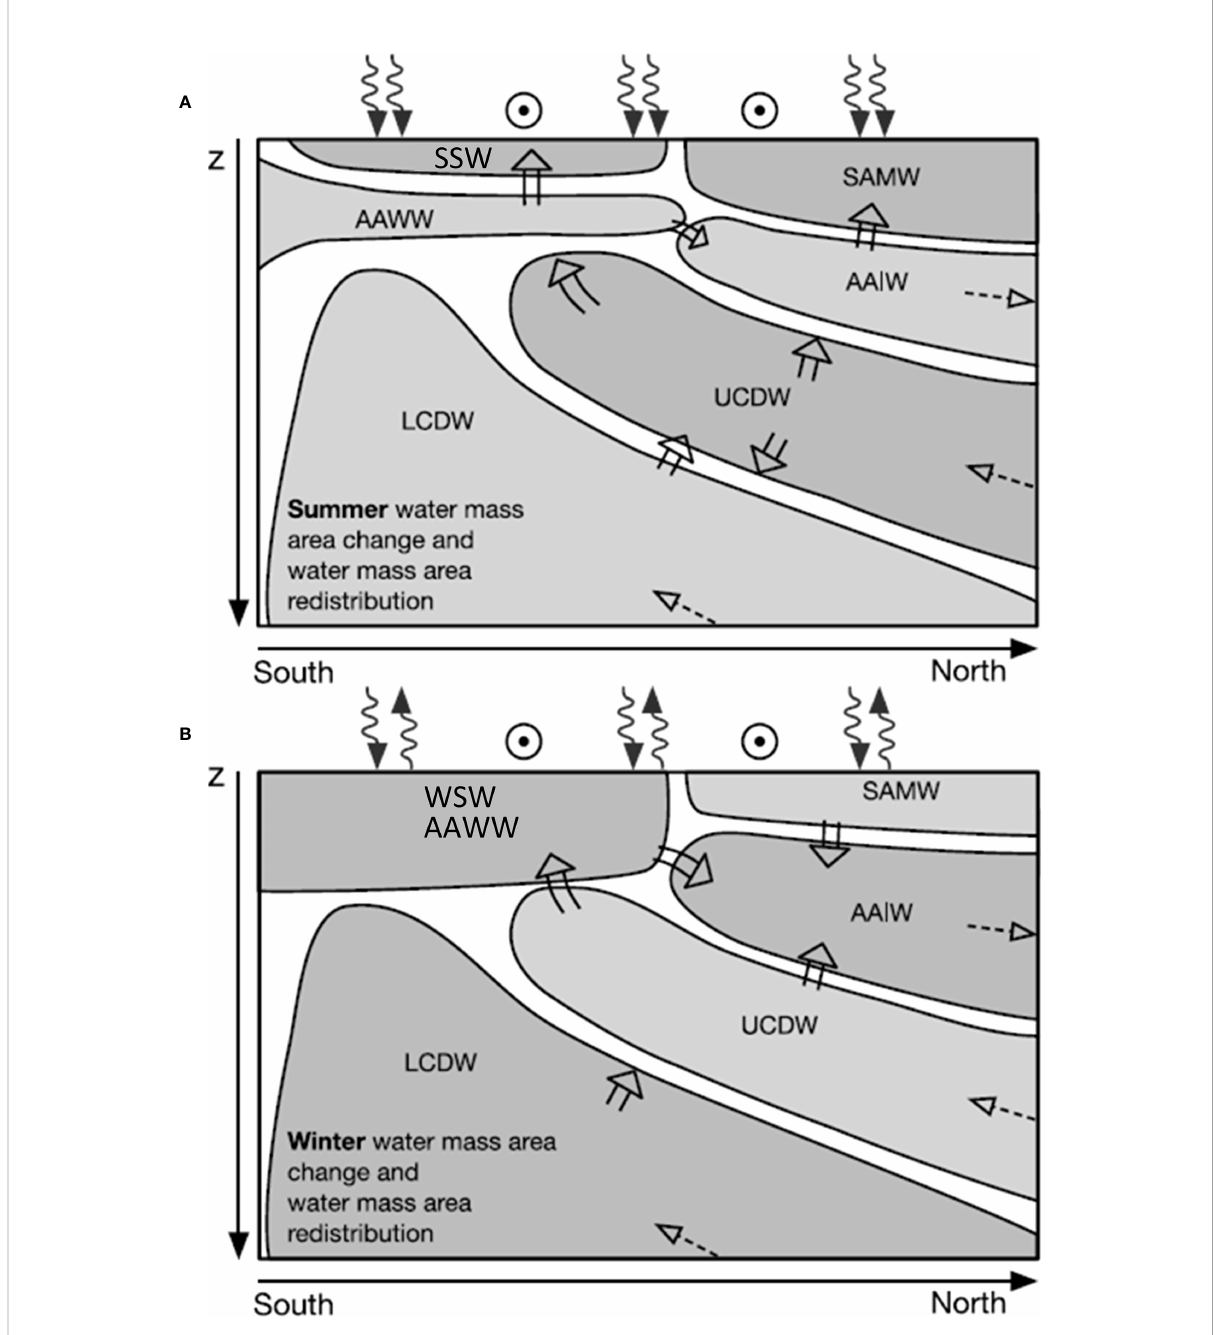
FIGURE 3 Schematic showing the changes in the distributions of water masses during (A) summer and (B) winter in depth vs. latitude coordinates. The black circles with dots represent the direction of the zonal winds out of the page. SSW, Summer Surface Water; WSW, Winter Surface Water; AAWW, Antarctic Winter Water; SAMW, Subantarctic Mode Water; AAIW, Antarctic Intermediate Water; UCDW/LCDW, Upper/Lower Circumpolar Deep Water. Figure modi fi ed from Evans et al.